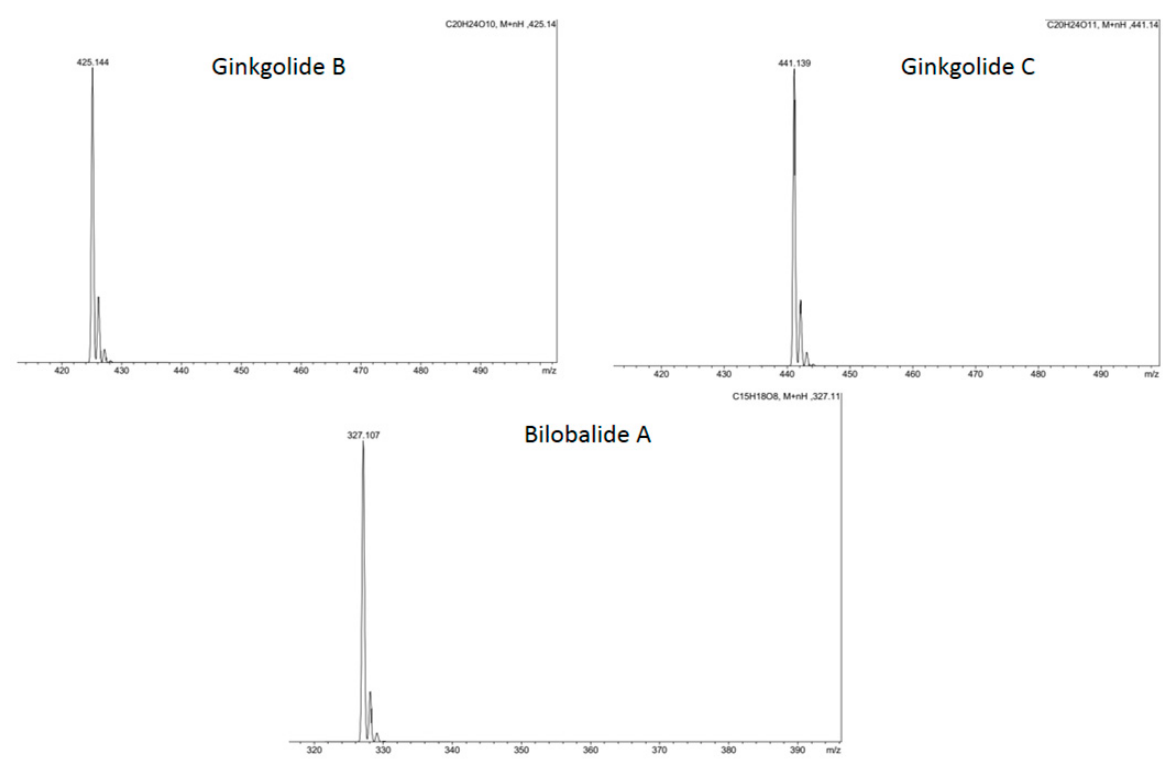
Figure 3. HRMS spectra of selected individual compounds.